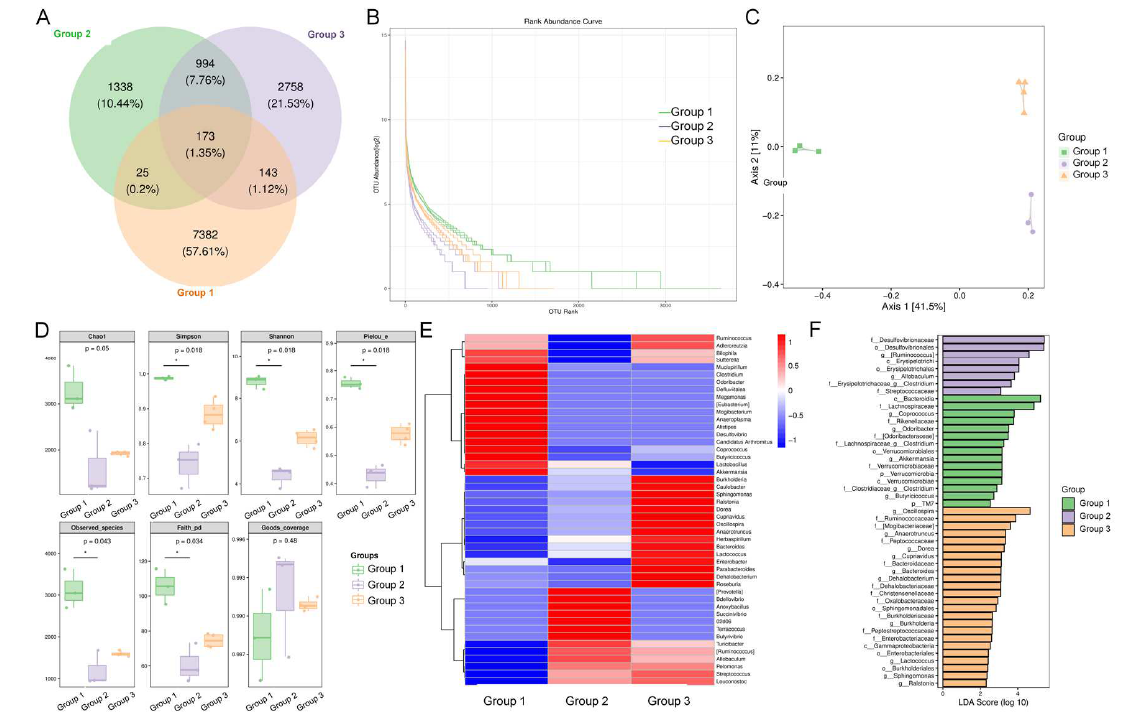
Figure 4. ADe treatment regulated the intestinal microbiota. ( A ) Venn diagram. ( B ) Rank abundance curve. ( C ) Two-dimensional unweighted UniFrac-based PCoA ordination of the mice intestinal mi- crobiota. A closer projection distance between two points on the coordinate axis indicates a higher similarity in the community composition of the two samples in the corresponding dimensions. ( D ) Alpha diversity analysis of the experimental groups. Data are shown as the mean ± S.E.M. and sta- tistical significance was determined via the Kruskal–Wallis test. * p < 0.05 versus NCD-fed mice. ( E ) Heatmap of the top 50 bacterial genera using the unweighted UniFrac distance from the cecal con- tent samples. ( F ) Histogram of LDA effect values of marker species based on LEfSe analysis (LDA >